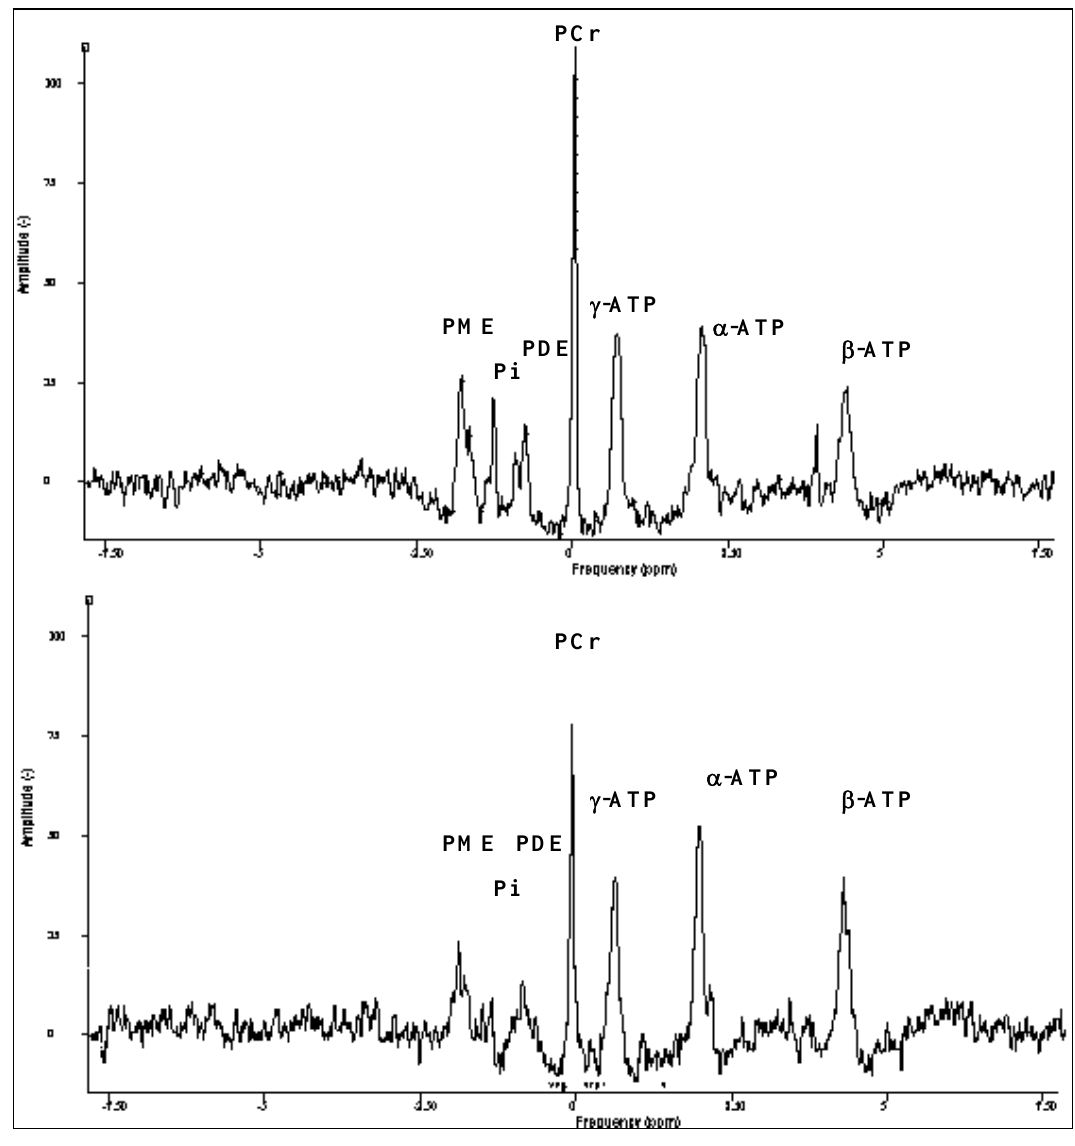
FIGURE 1. Illustrates global brain 31 P MRS imaging spectra indicating phosphorus-containing peaks obtained following the first night of recovery sleep in control subject (top) and MM subject